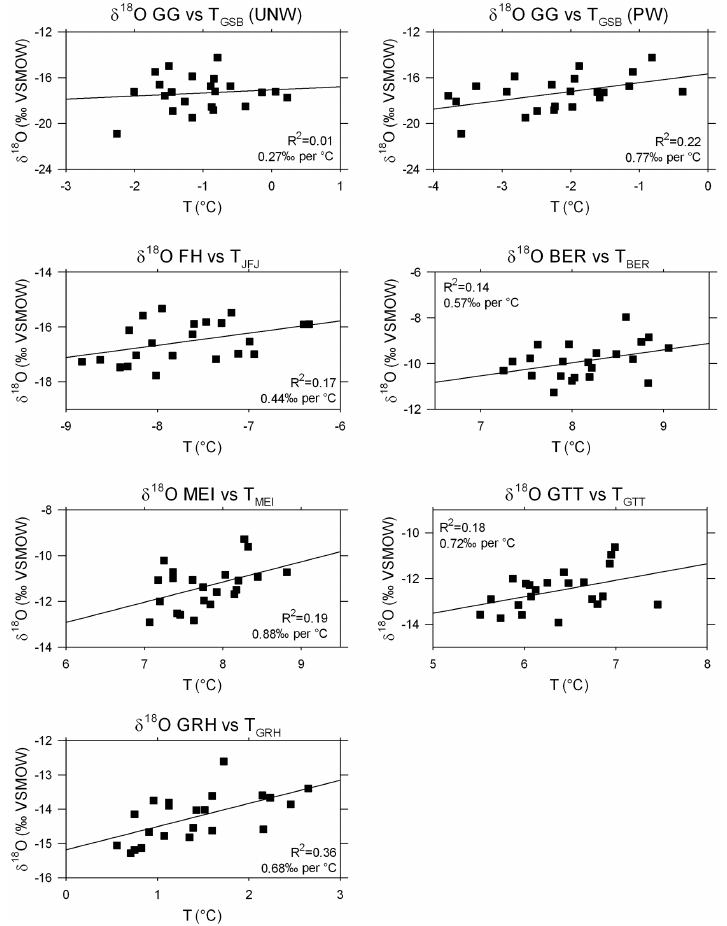
Figure 7. Scatter plots of annual temperature and δ 18 O data over the common period 1971–1993. The sites are denoted as follows: Grenzgletscher (GG), Grand Saint Bernard (GSB), Fiescherhorn (FH), Jungfraujoch (JFJ), Bern (BER), Meiringen (MEI), Guttannen (GTT), Grimsel Hospiz (GRH). “UNW” stands for the unweighted temperature and “PW” for precipitation-weighted